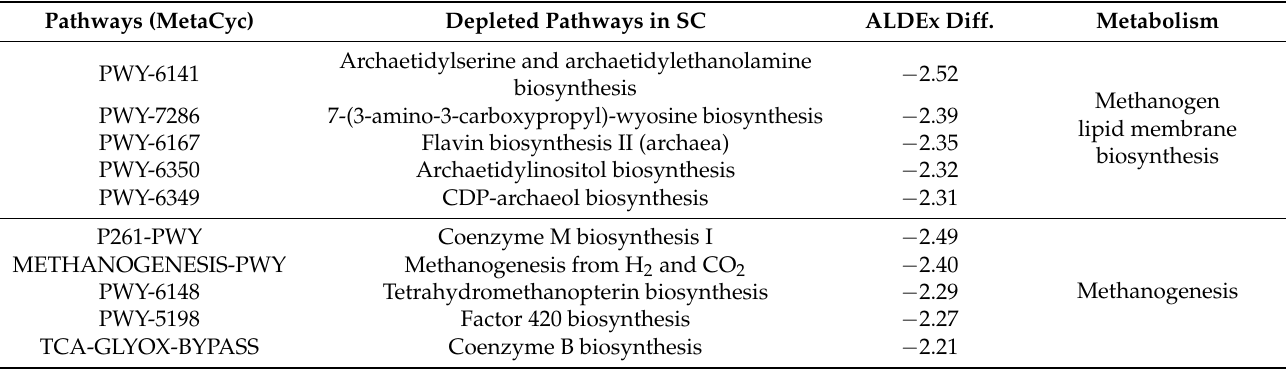
Table 2. Depleted metabolic pathways in the SC compared to the